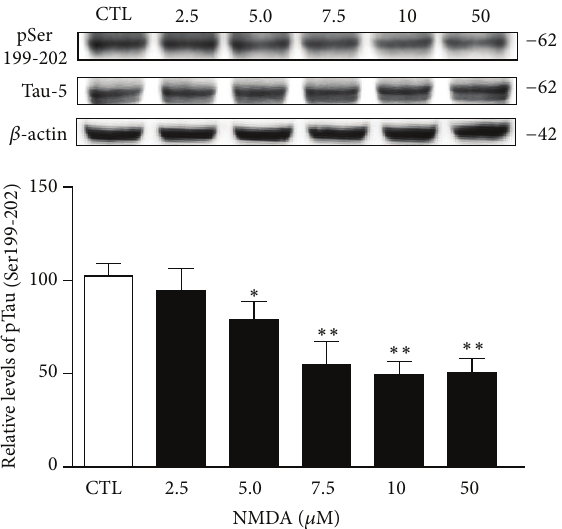
Figure 1: Tau phosphorylation at Ser199-202 sites is reduced after NMDA treatment. Phosphorylation and protein levels were esti- mated by Western blotting of cell extracts (40 𝜇 g proteins) obtained from hippocampal slices treated with increasing concentrations of NMDA for 1 hour. Phosphorylated Tau levels at Ser199-202, expressed relative to total Tau (Tau-5) levels, were measured in slices treated with or without NMDA. The data were expressed as percentages of control values and are means ± S.E.M. of 3 measurements per cell extract obtained from 8 different rats. For statistical analysis, one-way ANOVA was followed by Newman- Keuls post hoc test. ∗ 𝑃 < 0.05 , ∗∗ 𝑃 < 0.01 , NMDA-treated versus control.